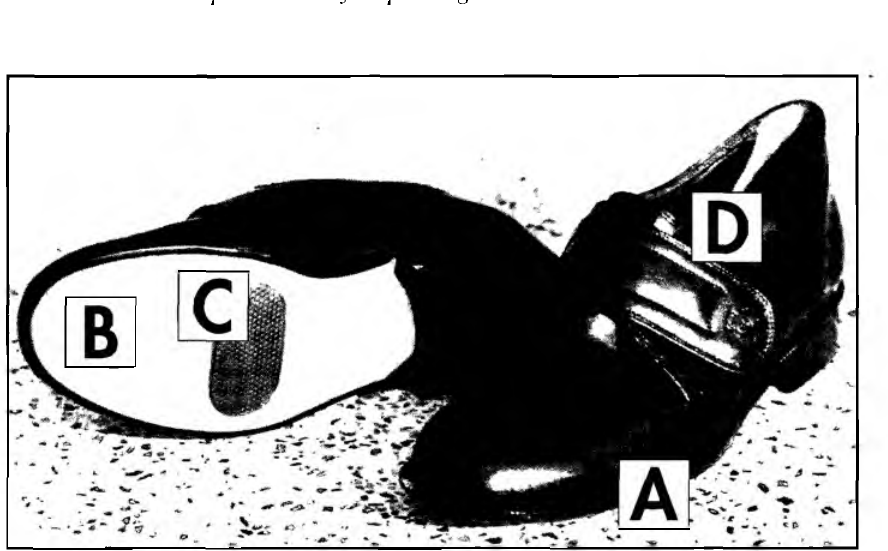
Figure 1: Bally-Valens-Rehab improve gaii and at the mean time look like normal shoes. The shoes have a forefoot rocker (A) positioned dorsally to reduce activity of the toe flexors during stance and to facilitate heel off after mid stance. The forefoot leather sole (B) reduces toe drag during swing. The non slip inlay (C) in the forefoot sole give a secure stance. The firm and high support of the rear foot (D) prevents supination during